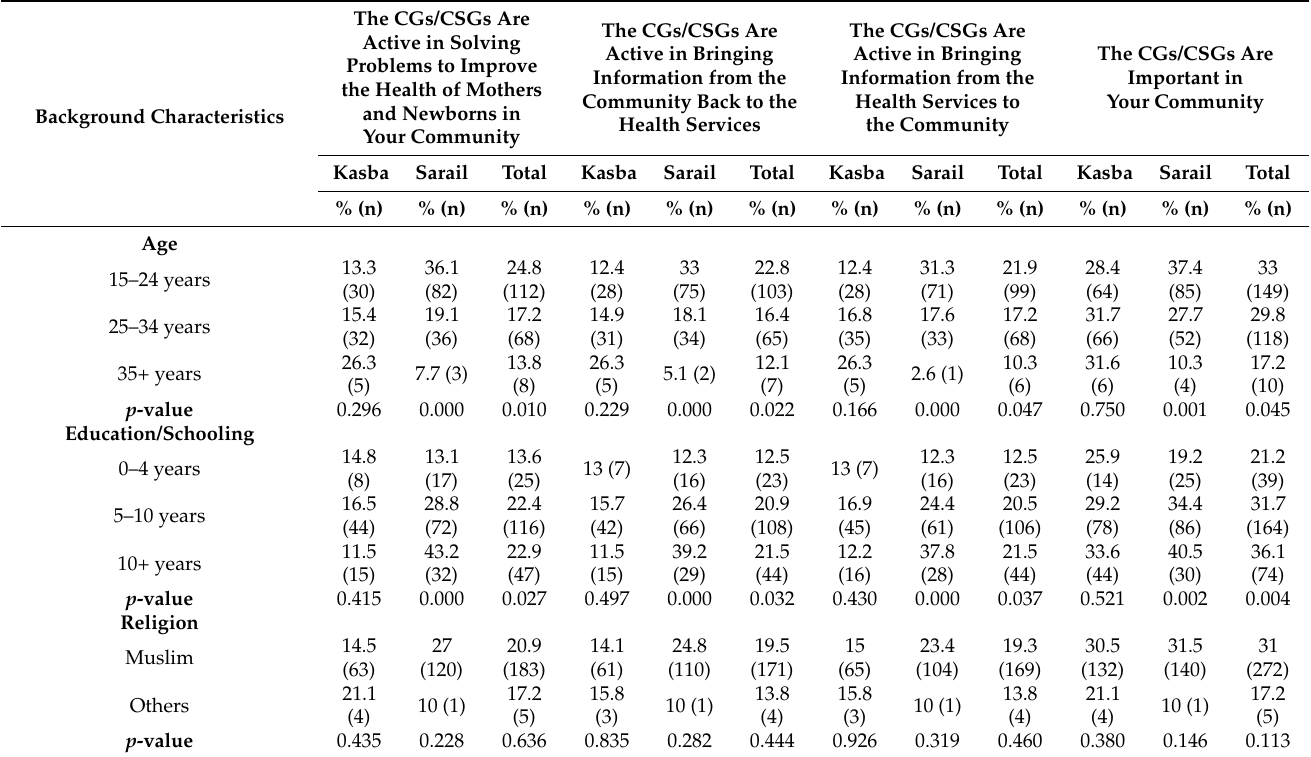
Table 3. Women’s perception regarding CGs and CSGs (Kasba = 452 and Sarail =